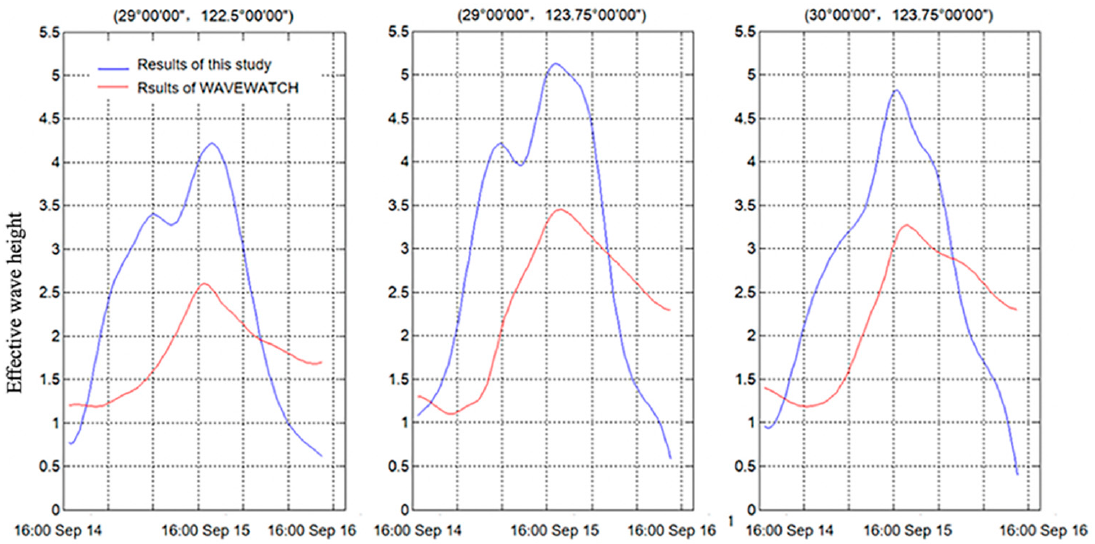
Figure 8. Verification results of effective wave height.